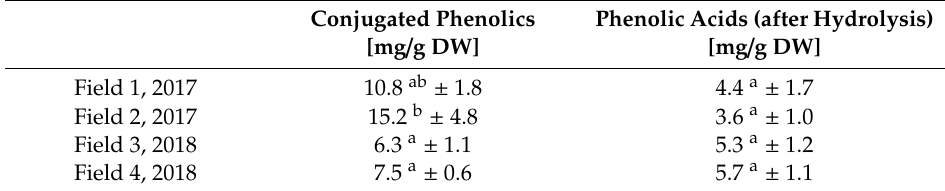
Table 3. Content of phenolic compounds in broccoli